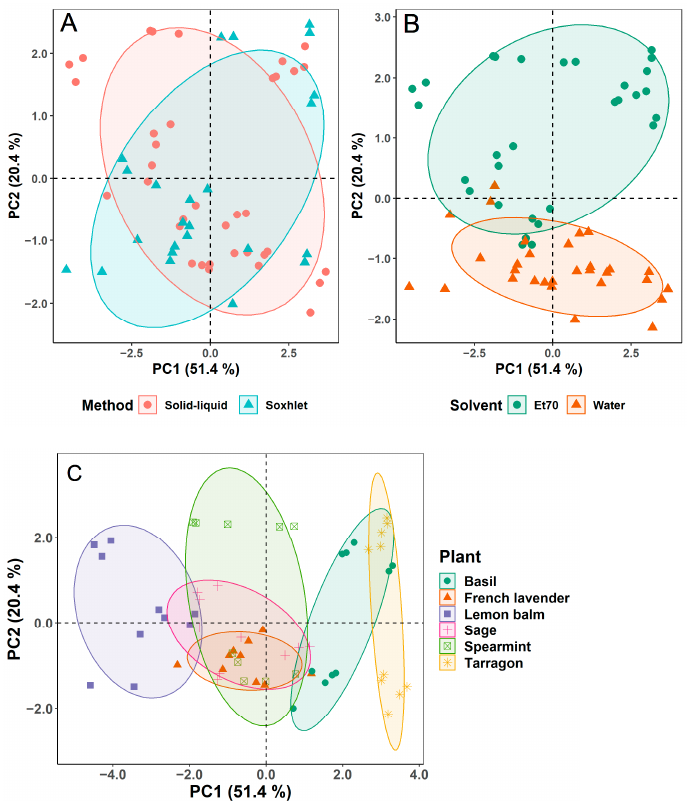
Figure 2. Score plots of the first two components of the principal component analysis (PCA) grouped by extraction method ( A ), solvent ( B ) and plant type ( C ). In the original publication, there was a mistake in Figure 3 (page 10) as published. “Rosemary” should be replaced by “French lavender”. The corrected Figure 3 appears below.